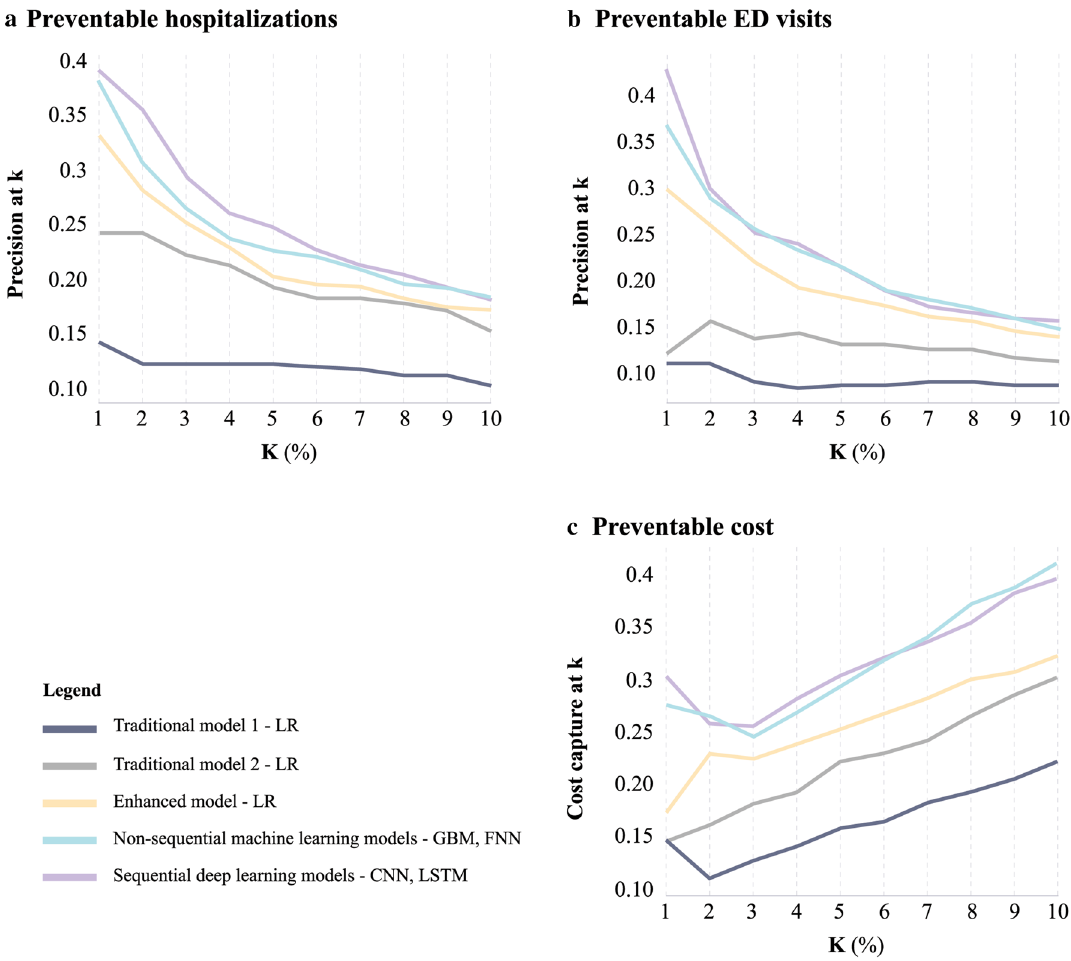
Figure 2. Predictive Models to Assess the Precision at k and Cost Capture at k for the Prediction of Preventable Hospitalizations, Preventable Emergency Department Visits, and Preventable Costs among Heart Failure Patients. ( a , b ) precision (PPV) at k for different thresholds (k). Precision at k considers only the topmost patients (top k%) ranked by the model, and therefore presents the accuracy of the model’s ranking at a certain threshold. E.g. precision at 10% corresponds to PPV among the patients ranked by each model at the top decile. ( c ) cost capture at k for different thresholds (k), E.g. cost capture at 10 corresponds to the ratio between the predicted preventable costs to the actual preventable costs among the patients ranked by each model at the top decile. The figure was edited using Adobe Illustrator Creative Cloud version 24.2.1 21 . CNN, Convolutional Neural Network; FNN, Feedforward Neural Network; GBM, Gradient Boosting Model; LSTM, Long Short- Term Memory; LR, Logistic Regression; PPV, Positive Predictive